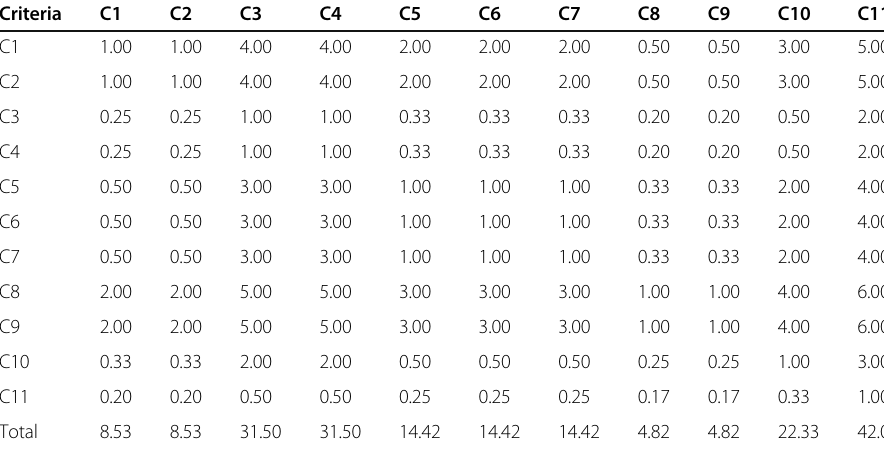
Table 4 Pairwise comparison matrix for subcriteria Criteria